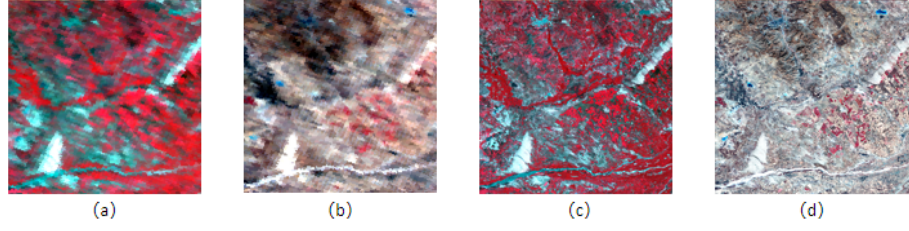
Figure 10. Test data from the AHB dataset. These figures exhibit the false color composite images using band 4, band 3, and band 2. ( a , c ) are the MOIDS and Landsat images on 29 August 2017, respectively. ( b , d ) are the MOIDS and Landsat images on 4 January 2018, respectively.